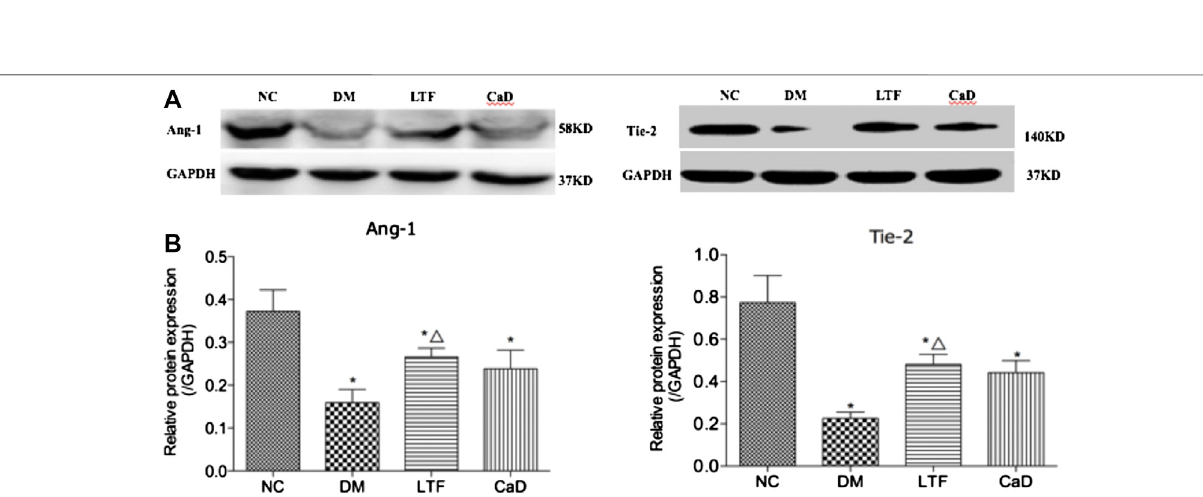
Frontiers in Pharmacology |